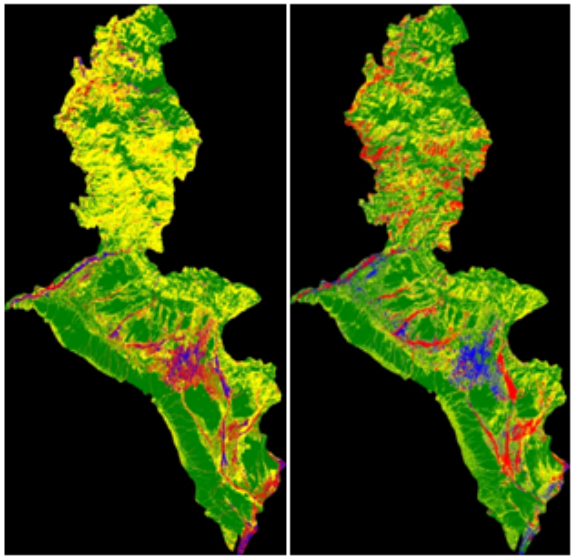
Figure 9: Collection of output Data generated by Sentinel-2 and LANDSAT-8 at resolution 30m by Support Vector Machine